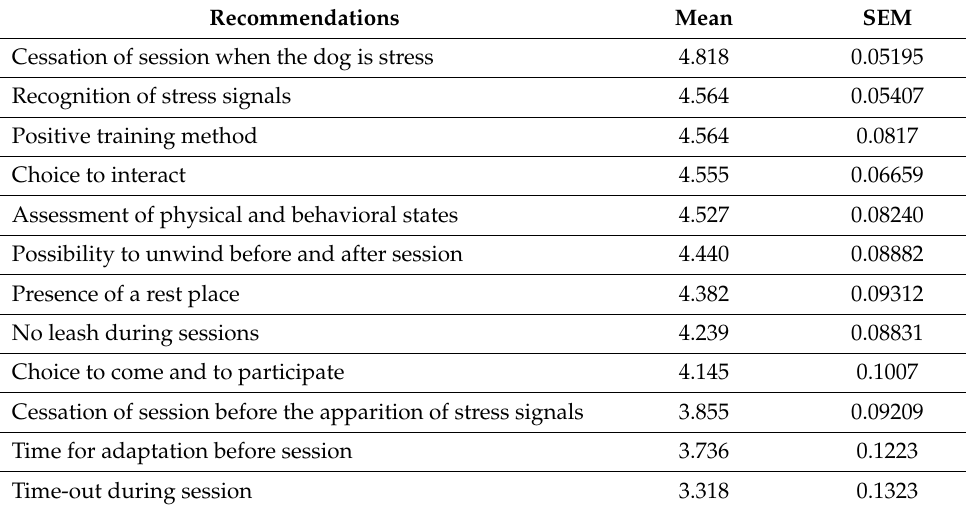
Table 6. This table represents the answers to the question “The following is a cross-reference of the main guidelines found in the studies/associations. Indicate for each one whether you apply it never, rarely, sometimes, often, all the time »; n = 111 complete